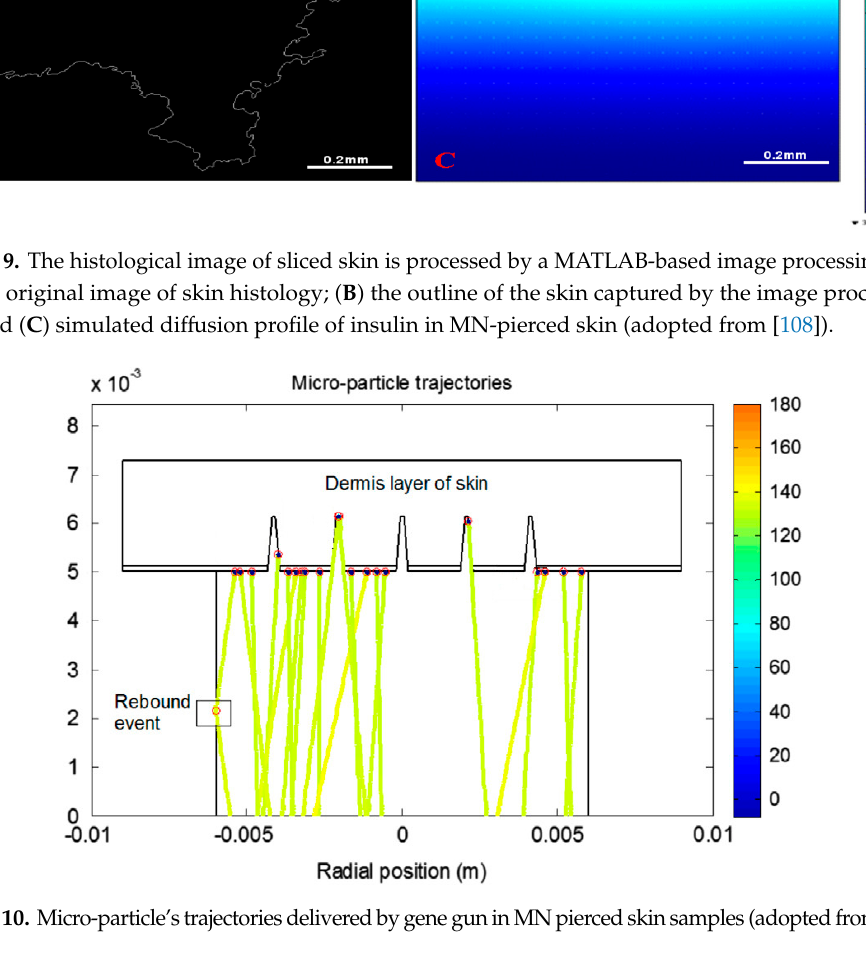
Figure 10. Figure 11. Micro-particle’s trajectories delivered by gene gun in MN pierced skin samples (adopted from [77]).